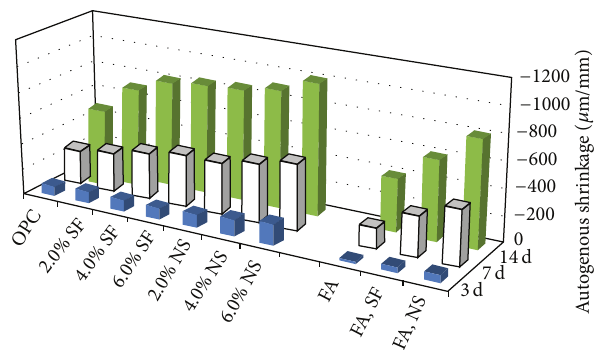
Figure7: Autogenous shrinkageofcompositecement pastesat early